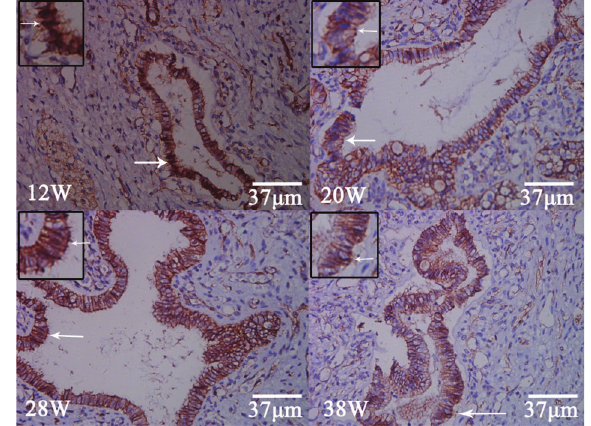
Figure 3. Positive expression of b -catenin (arrows) in the common bile duct cells in the membrane, cytoplasm and nucleus at different fetal stages (12, 20, 28, and 38 weeks).